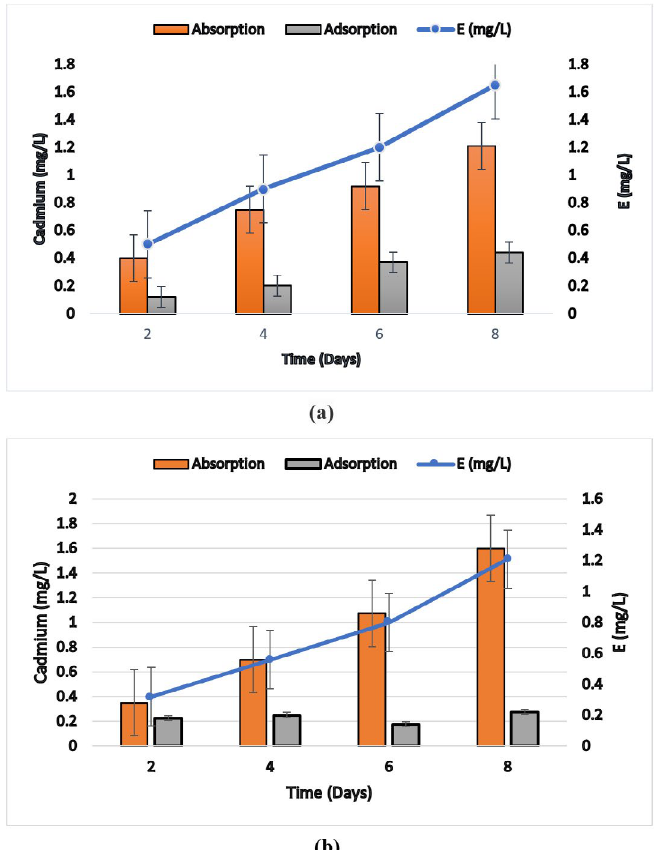
Fig. 3. Biosorption capability of a) Bacillus sp.ECd004 b) Cuprividus sp. SCd005 growing in culture medium supplemented with 2 mg/l of